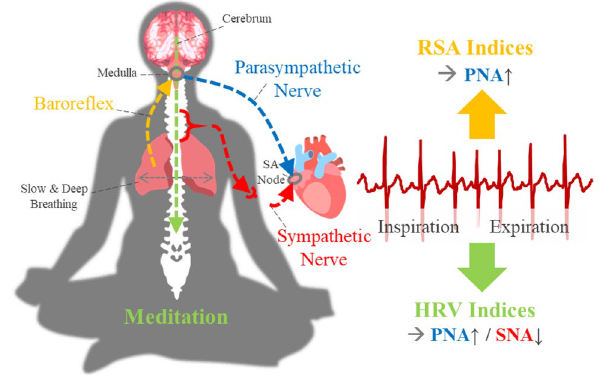
Figure 1. Meditation and single-lead ECG.